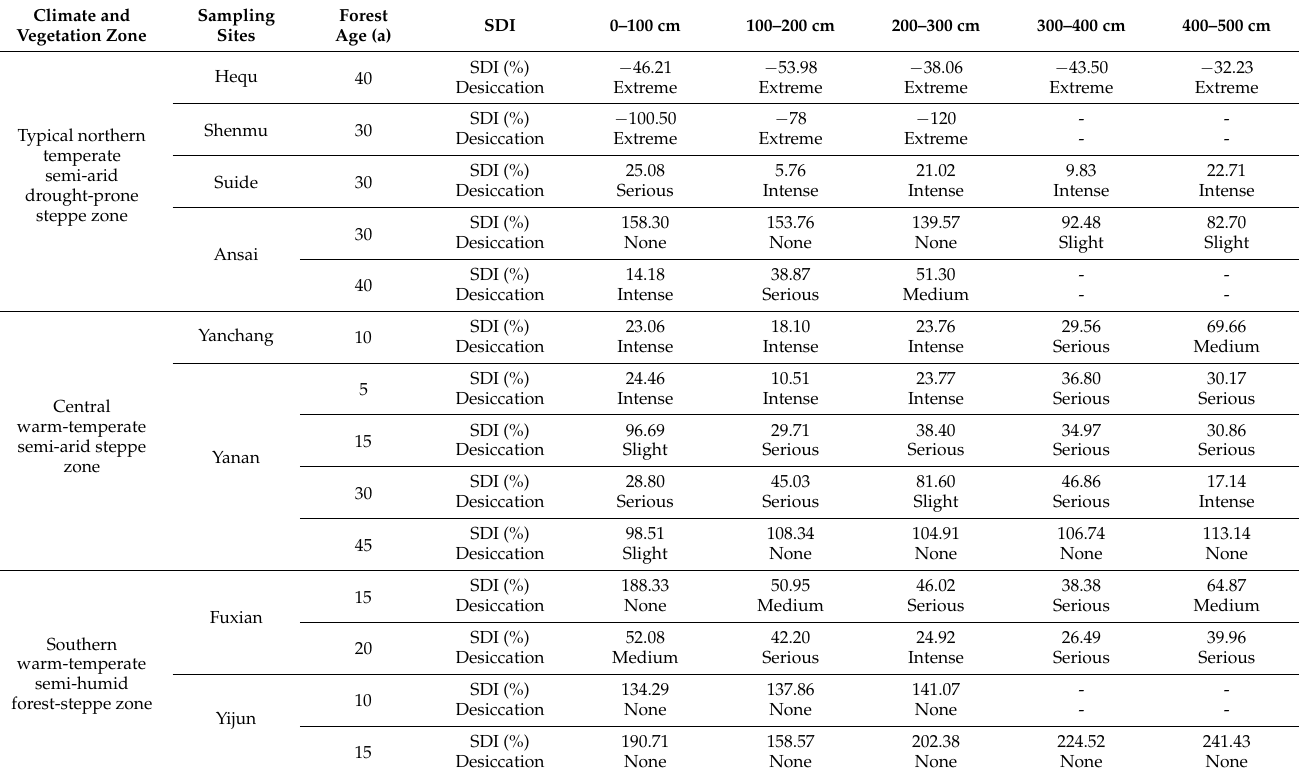
Figure 5. Distribution of desiccated-soil layers under R. pseudoacacia forests in the southern, warm- temperate, semi-humid forest-steppe zone of the Loess Plateau. Note, ( a , b ) in Figure 5 were repre- sented as sampling sites in Fuxian and Yijun, respectively. Table 7. Distribution of profile desiccated-soil layers under R. pseudoacacia on the Loess